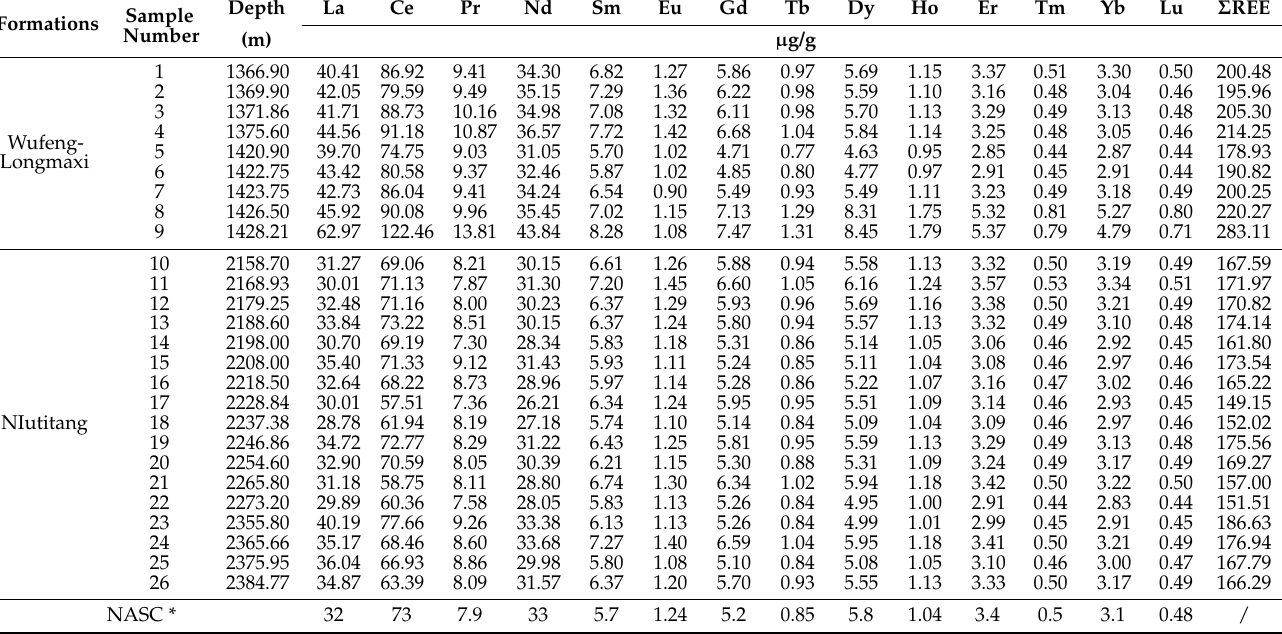
Table 4. Rare earth elements abundances of Wufeng-Longmaxi and Niutitang